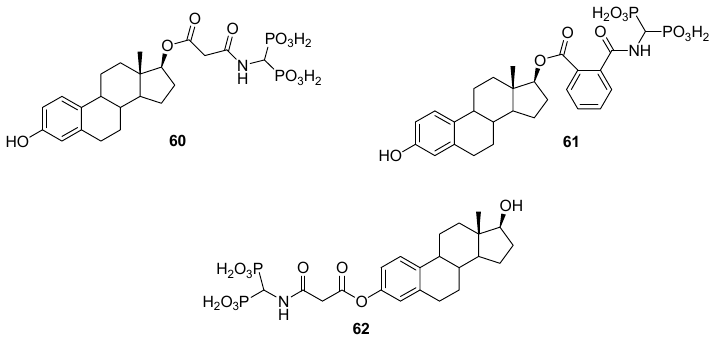
Scheme 30. Representative structures of bone-specific estrogens.